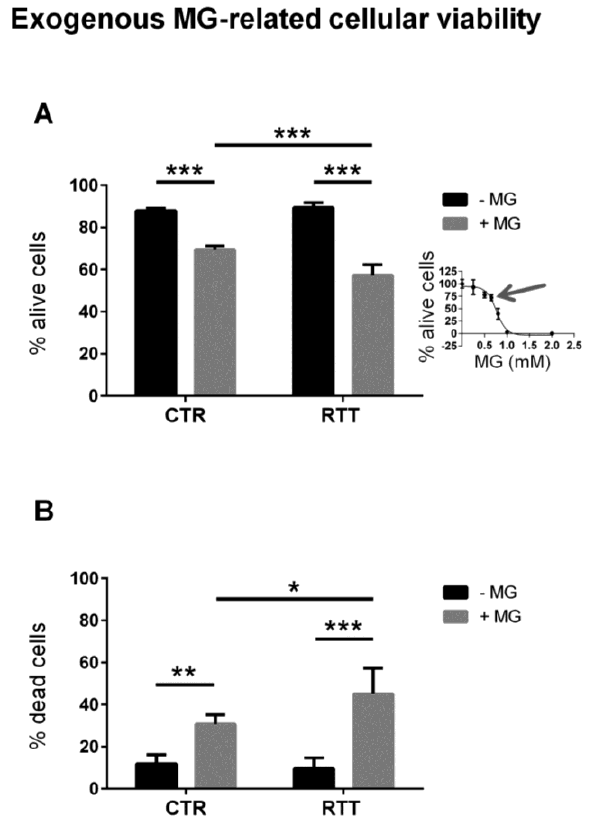
Figure 3. Cell survival from a 24-h exogenous MG challenge. ( A ) Cell viability of CTR and RTT fibroblasts, upon MG treatment; ( B ) cell death of CTR and RTT fibroblasts following MG challenge. Values were expressed as means ± SD. The chosen MG concentration (650 μM) represented the 30% reduction of live cells (IC 30 , indicated by the arrow), calculated through a 4P-logistic regression curve derived from a dose-response curve obtained by incubating cells with MG concentrations ranging from 0 to 2 mM (inset diagram). CTR, control; RTT, Rett syndrome; MG, methylglyoxal. * p < 0.05; ** p < 0.01; *** p < 0.001. Results were analyzed by Two-way ANOVA, with post hoc Tukey’s multiple comparisons test.